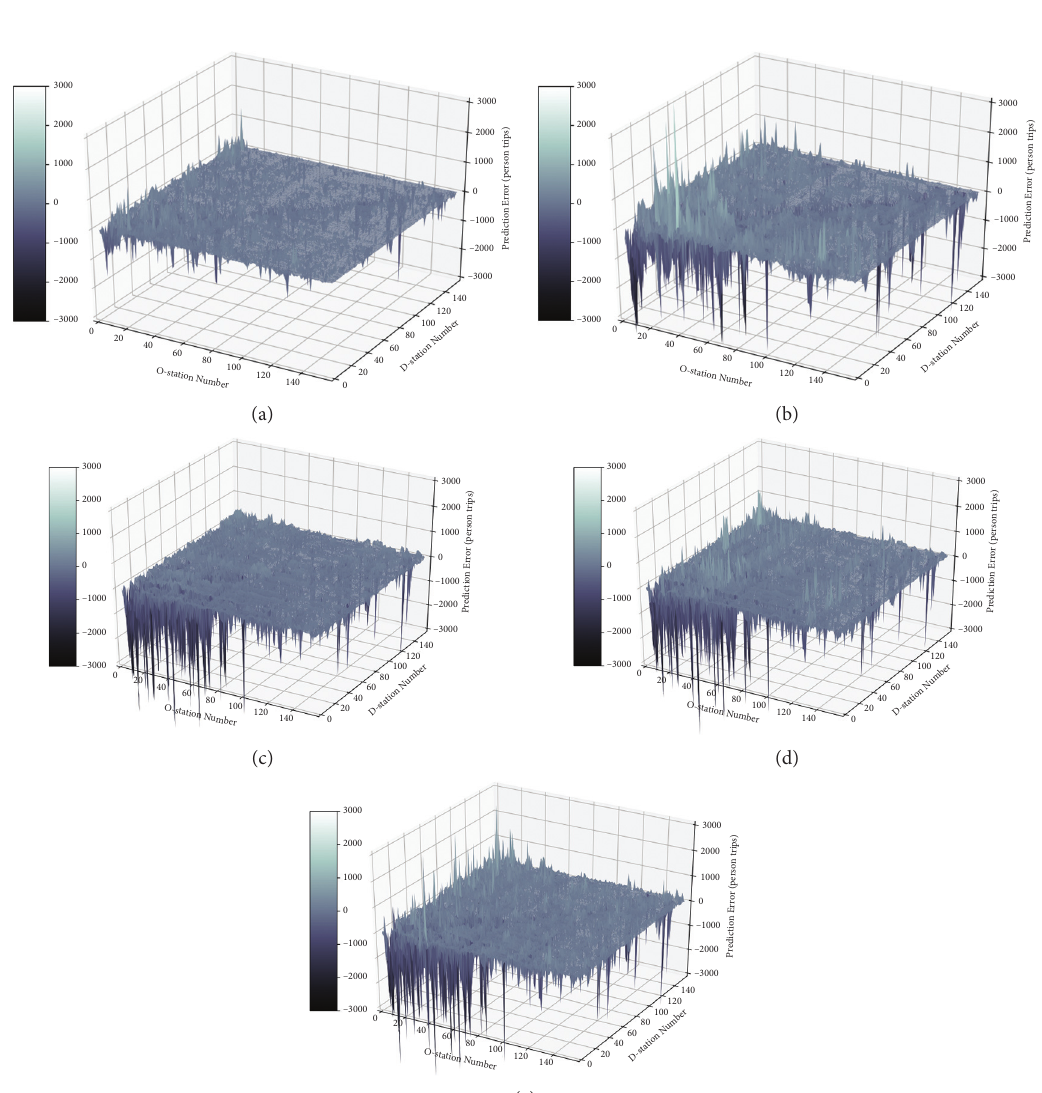
Figure 4: Prediction deviation of the proposed model and the comparison models on the New Year’s Day. (a) The proposed model. (b) The gravity model. (c) The support vector machine model. (d) The back propagation neural network model. (e) The radial basis function neural network model.